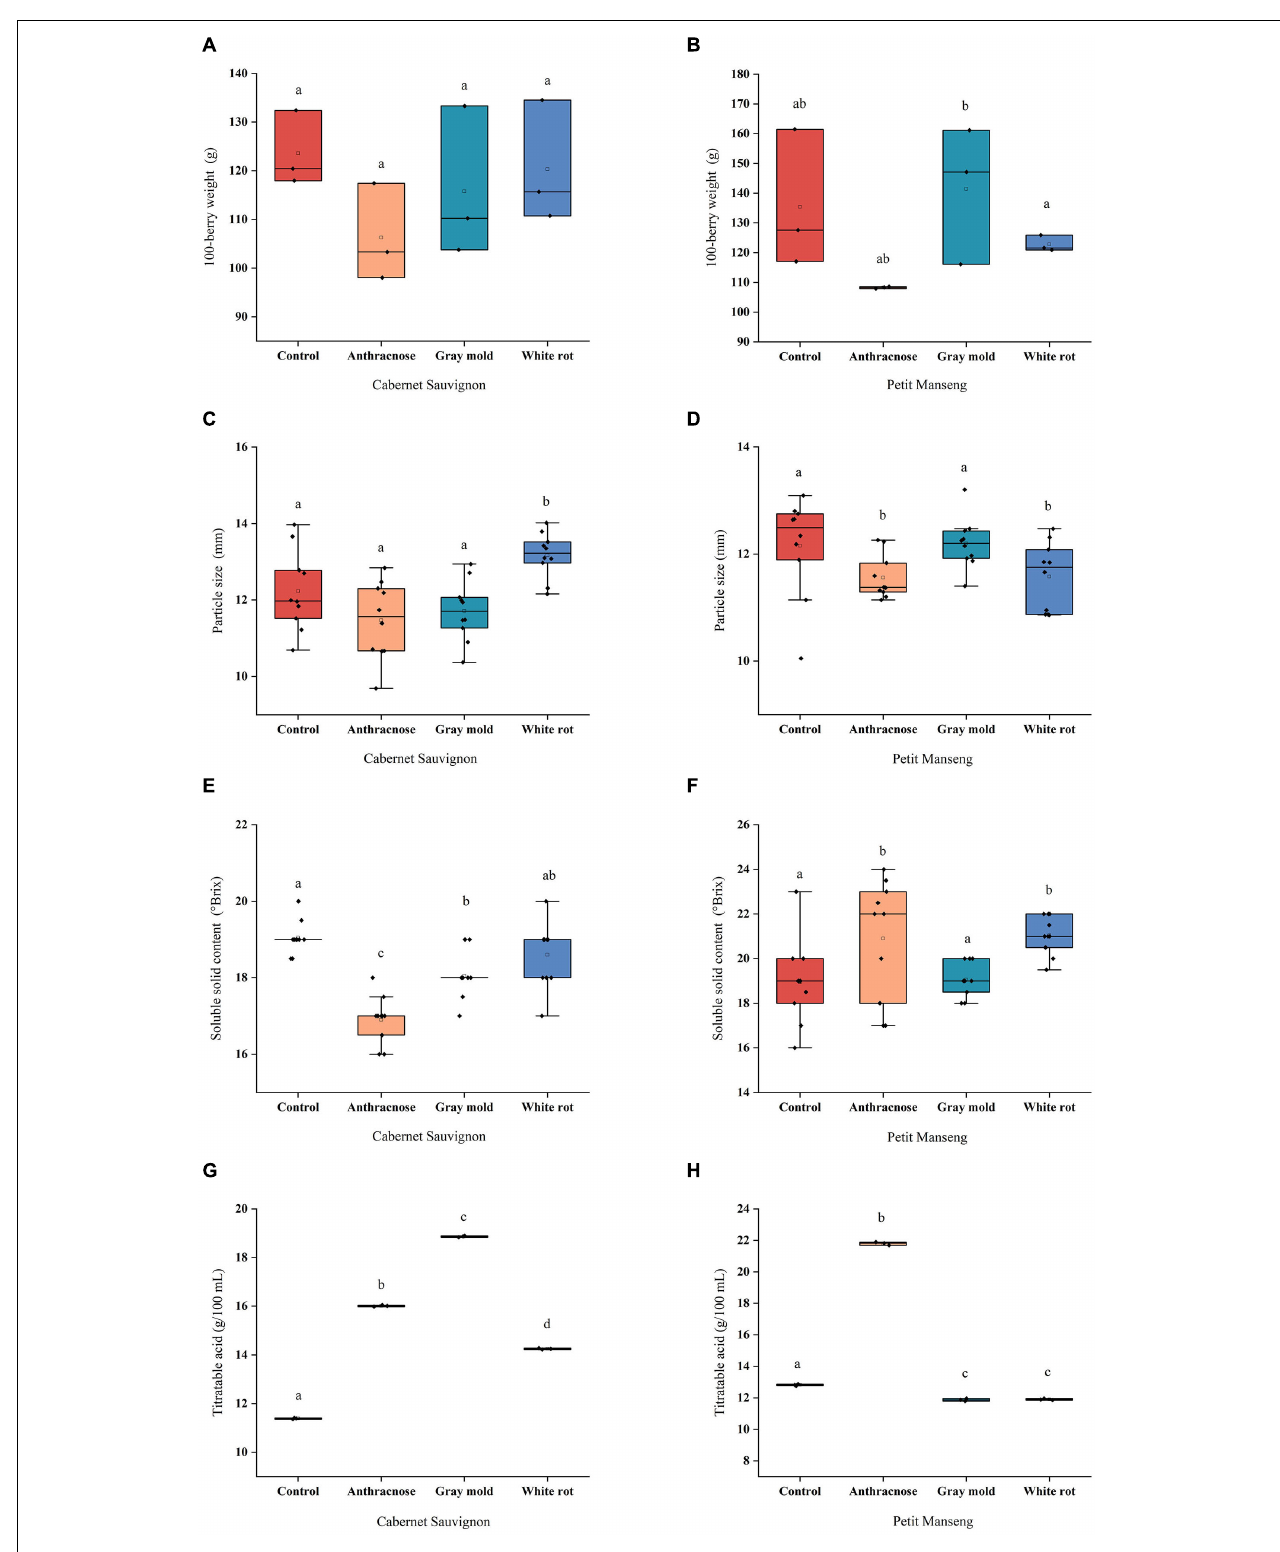
FIGURE 1 | The scattered boxplots show physicochemical parameters of Cabernet Sauvignon and Petit Manseng grapes: (A, B) 100-berry weight; (C, D) Particle size; (E, F) Soluble Solid Content (SSC); (G, H) Titratable acid (TA). Different letters (lower case) on the top of the bars represent significant differences among the investigated grape samples. Scattered boxplots show individual data points, median, average value, 25th, and 75th percentile.